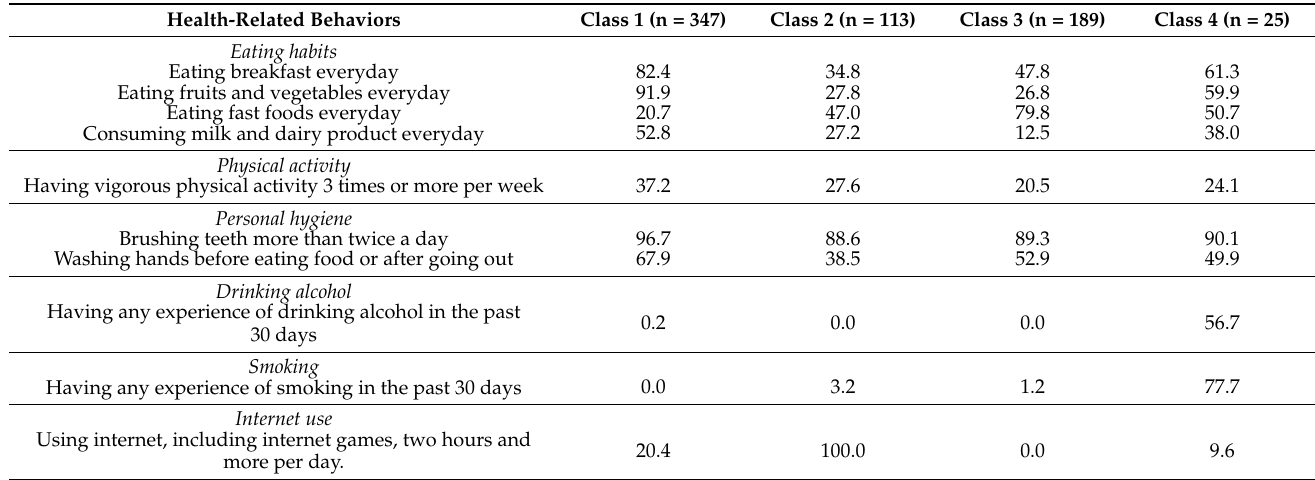
Table 3. Proportions of health-related behaviors of female adolescents by the classes